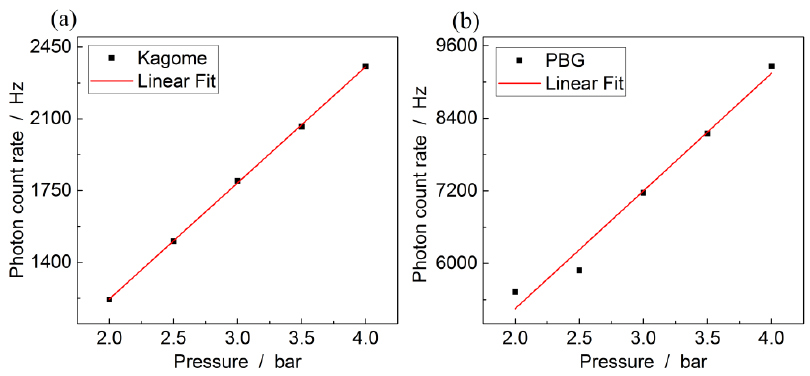
Figure 9. Integrated nitrogen signal plotted over the pressure for ( a ) kagomé-PCF and ( b ) PBG-PCF. The red curve shows a linear regression.